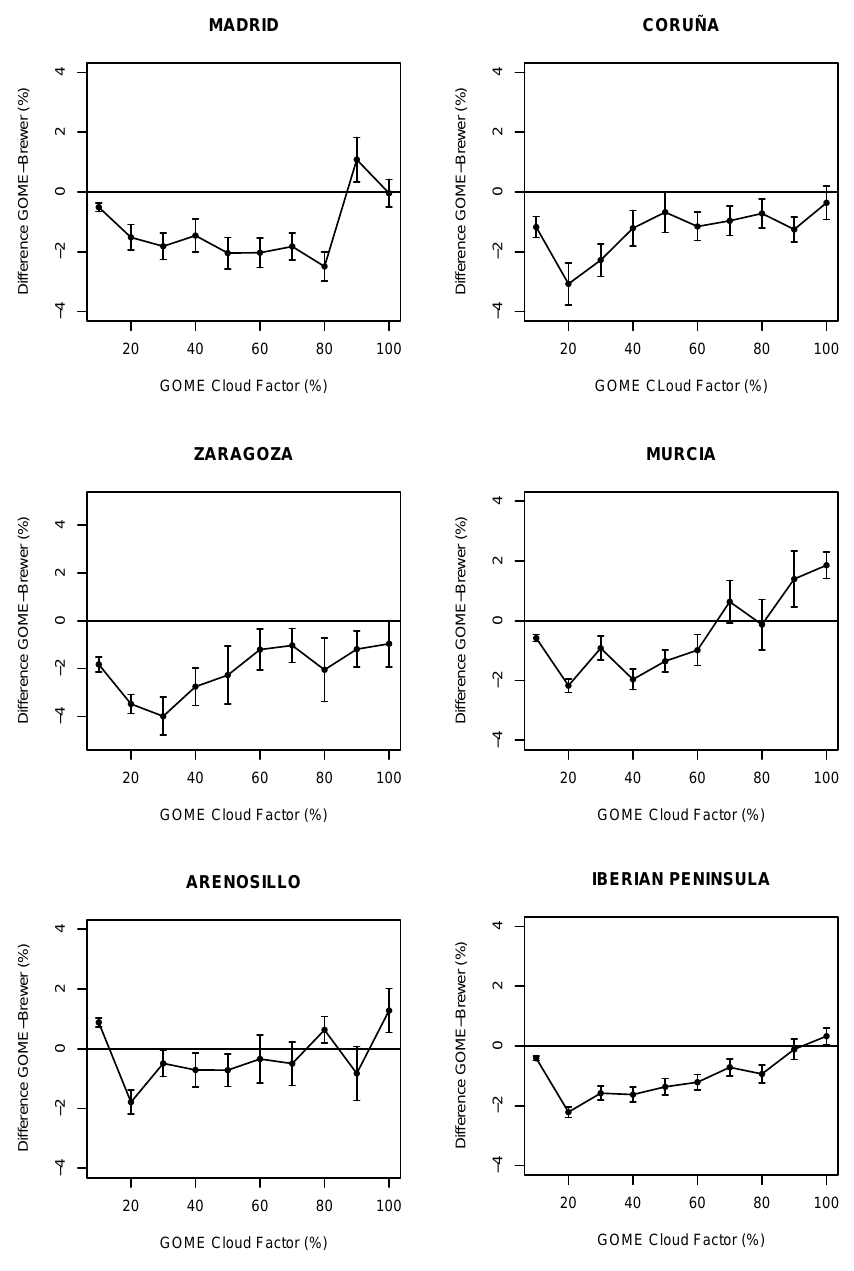
Fig. 4. Dependence of GOME-Brewer relative differences with the GOME Cloud Factor. (unit slope). The slopes and statistical parameters obtained in these correlations are shown in Table 2. The correla- tion between GOME and Brewer data is high for all sta- tions ( R 2 ∼ 0.92). Moreover, the noise is significantly low in all cases: RMSE=3.29% for Coru˜na (maximum) and RMSE=2.36% for Zaragoza (minimum). In addition, the MABE is lower than 3.3% in all locations. The standard error in the MABE is lower than 0.10%, indicating the statistical significance of the reported values. The analysis of all data together confirms these excellent results. The negative sign